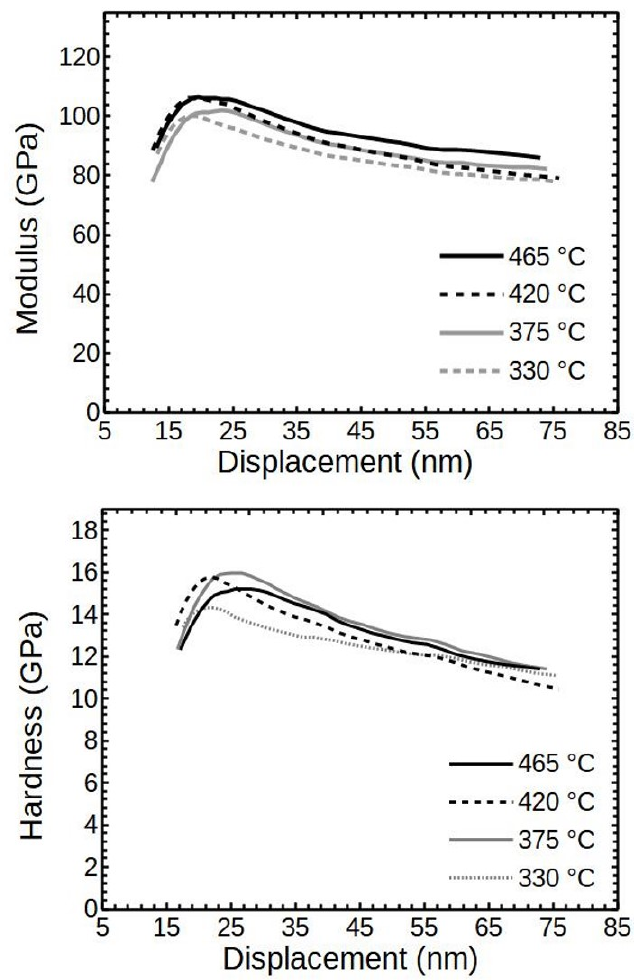
Figure 6. The averaged modulus and hardness values of ALD Cr 2 O 3 deposited at different temper- atures. Cr 2 O 3 layer thicknesses are around 68–85 nm.